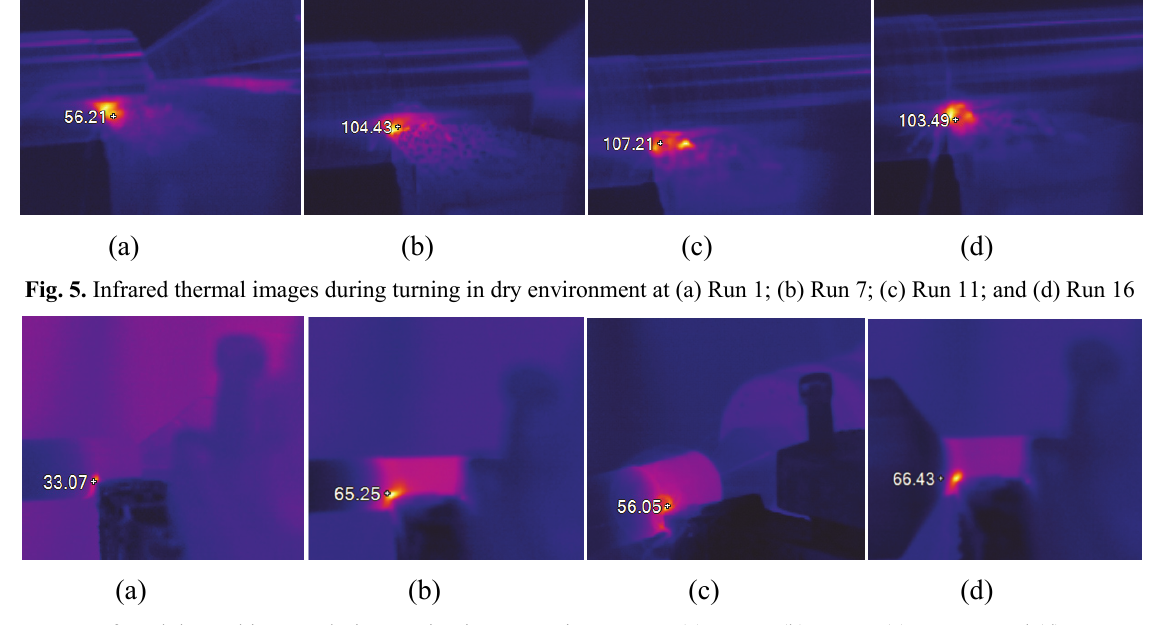
Fig. 6. Infrared thermal images during turning in SIC environment at (a) Run 1; (b) Run 7; (c) Run 11; and (d) Run